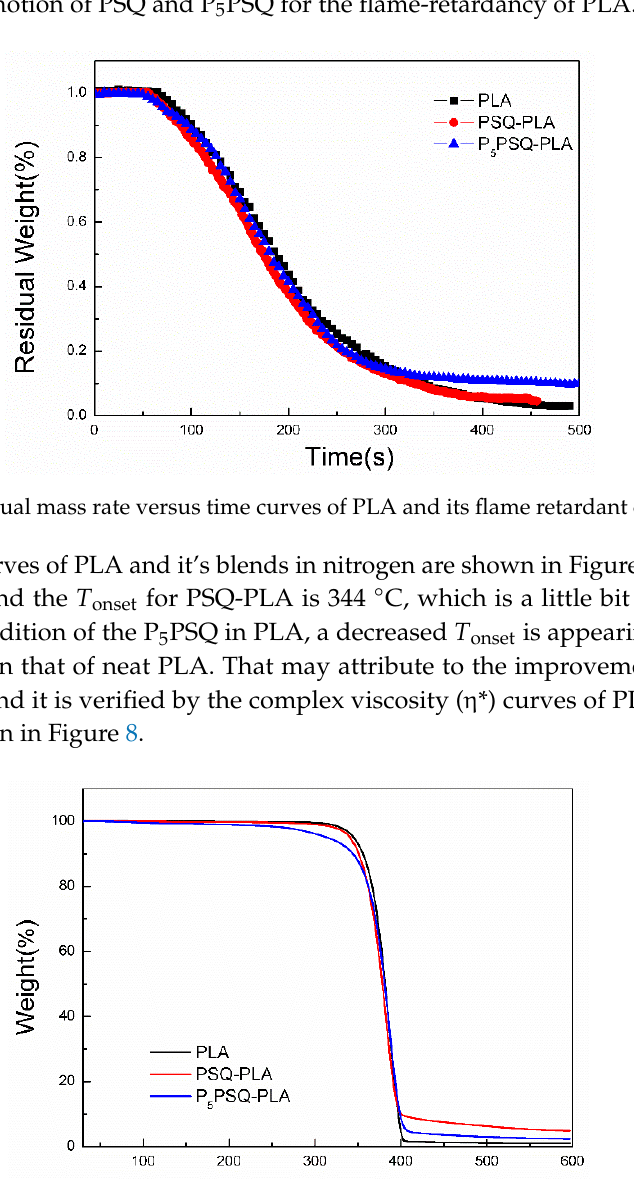
Figure 5. Total heat release versus time curves of PLA and its flame retardant composites.